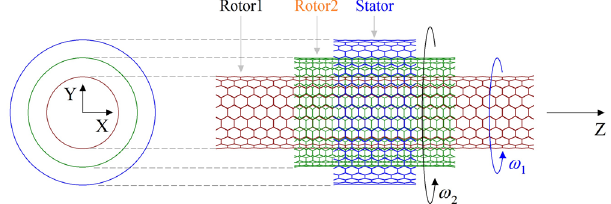
Figure 1. Schematic model of a rotary nanobearing from TWNTs with given middle and outer tubes. The inner tube (Rotor1) with a length of L1 nearby 6 nm in each model will act as rotor, which will be driven to rotate by the rotating middle tube (Rotor2) with a length of L2 = ~2.828 nm. The outer tube with a length of L3 = ~1.353 nm will be fixed as a stator in each model. All tube ends are hydrogenated. The input rotational frequency of Rotor2 is ω 2 , which leads to the output rotational frequency of Rotor1, i.e., ω 1 . In the present experiments, two types of nanobearings are involved, and the details are listed in Table 1.